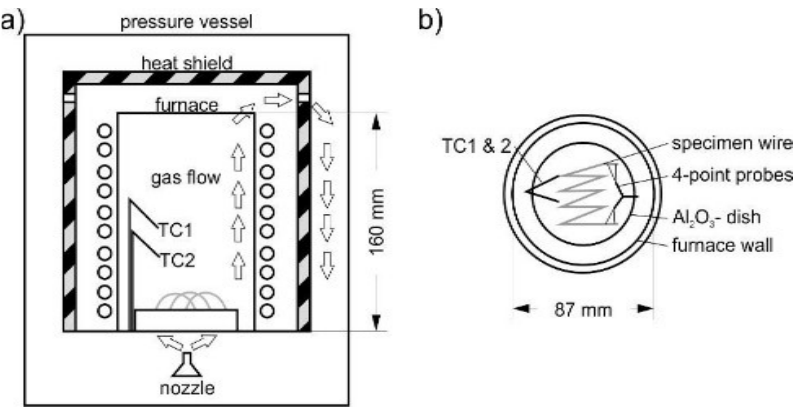
Figure 1. Schematic illustration of the experimental set-up inside the HIP-unit ( a ) side view, ( b ) top- view. ( b )